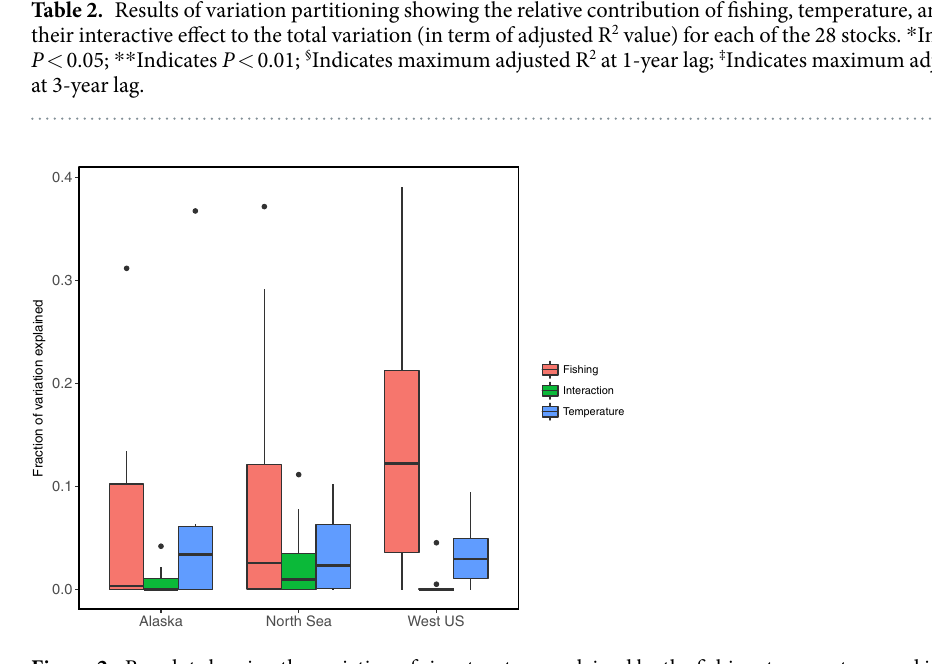
Figure 2. Boxplot showing the variation of size structure explained by the fishing, temperature, and interactive effect grouped by areas. The fraction of variation explained by fishing is significantly different from both temperature ( P = 0.005) and interaction ( P = 0.00046) in West